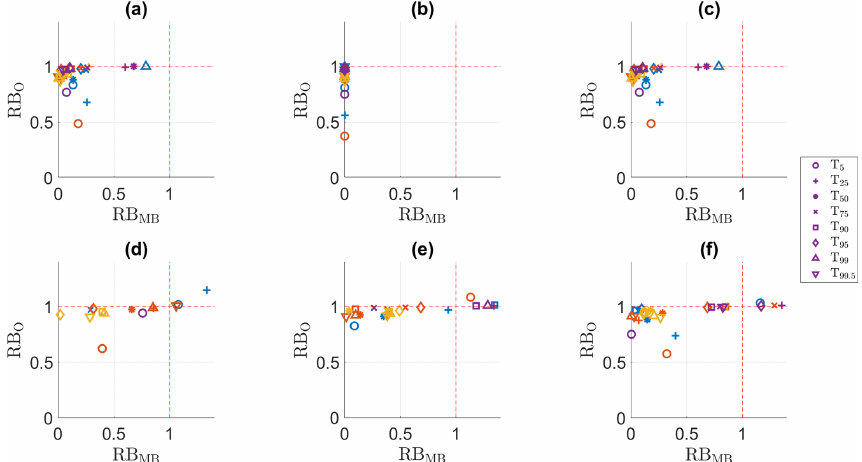
Figure 4. RB MB versus RB 0 for the temperature indices in the calibration period. (a) QDM, (b) mQDM, (c) MBCn, (d) MRQNBC, (e) dOTC, (f) R 2 D 2 . Winter: blue, spring: ochre, summer: yellow, autumn: purple.